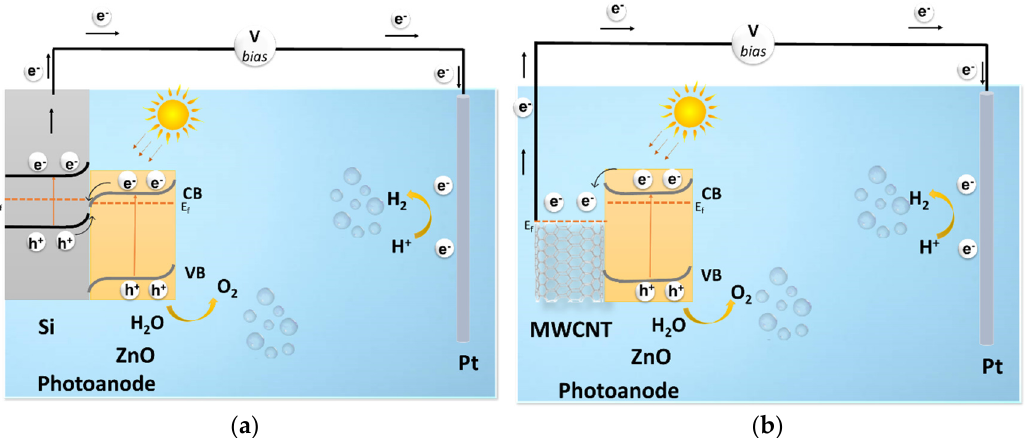
Figure 6. Schematic of PEC water splitting mechanism for Si-ZnO ( a ) and CNT-ZnO ( b ) photoanodes.